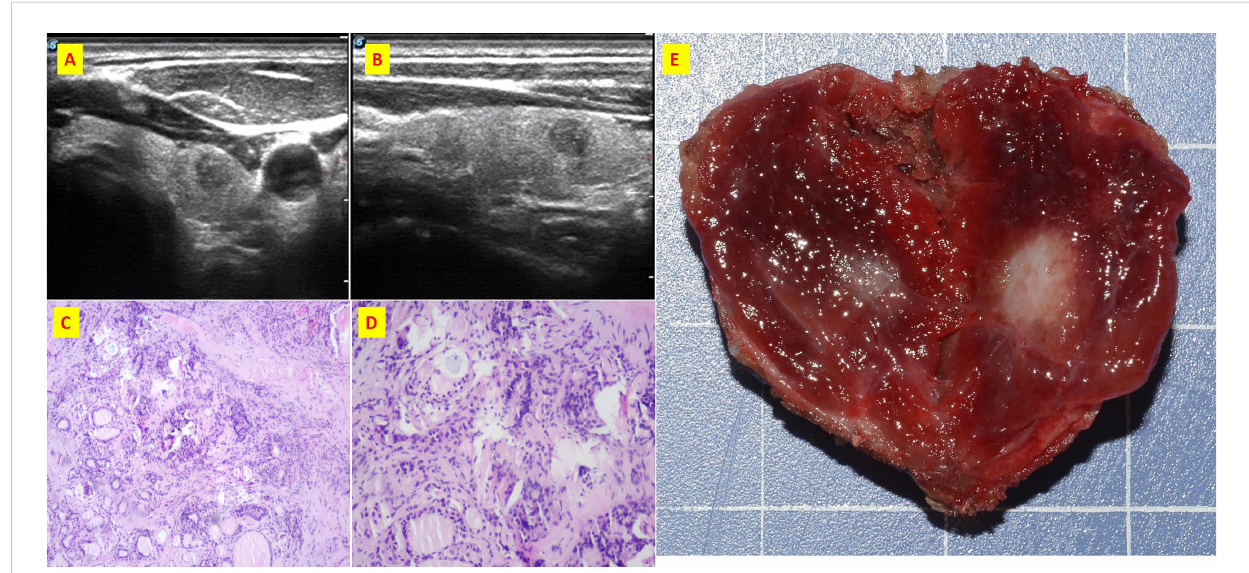
FIGURE 2 The patient n.2 that MTC and PTC was located in the same tumor. (A) ultrasound of transverse; (B) ultrasound of longitudinal; (C) Histological sections of HE x40; (D) Histological sections of HE x100; (E) Intraoperative resection of tumor pro fi le.